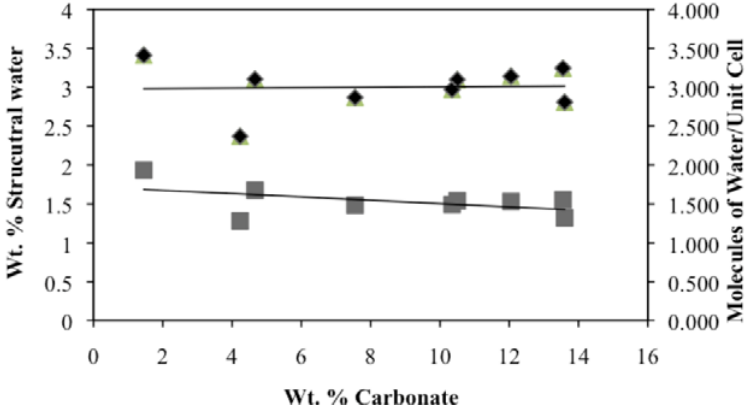
Figure 4. Weight percent structural water (black diamonds) and molecules per unit cell (gray squares) in fluorapatites prepared with a two-hour digestion period at 60 °C as a function of weight percent carbonate.